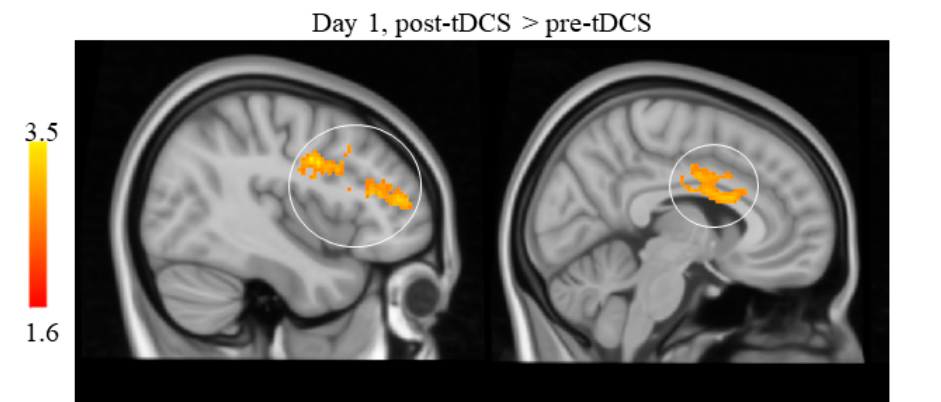
Figure 3. ASL statistical analysis between groups comparison. Anodal tDCS led to increased CBF in the lateral prefrontal cortex (LPFC) and midcingulate cortex (MCC) compared to sham tDCS after stimulation on day 1.